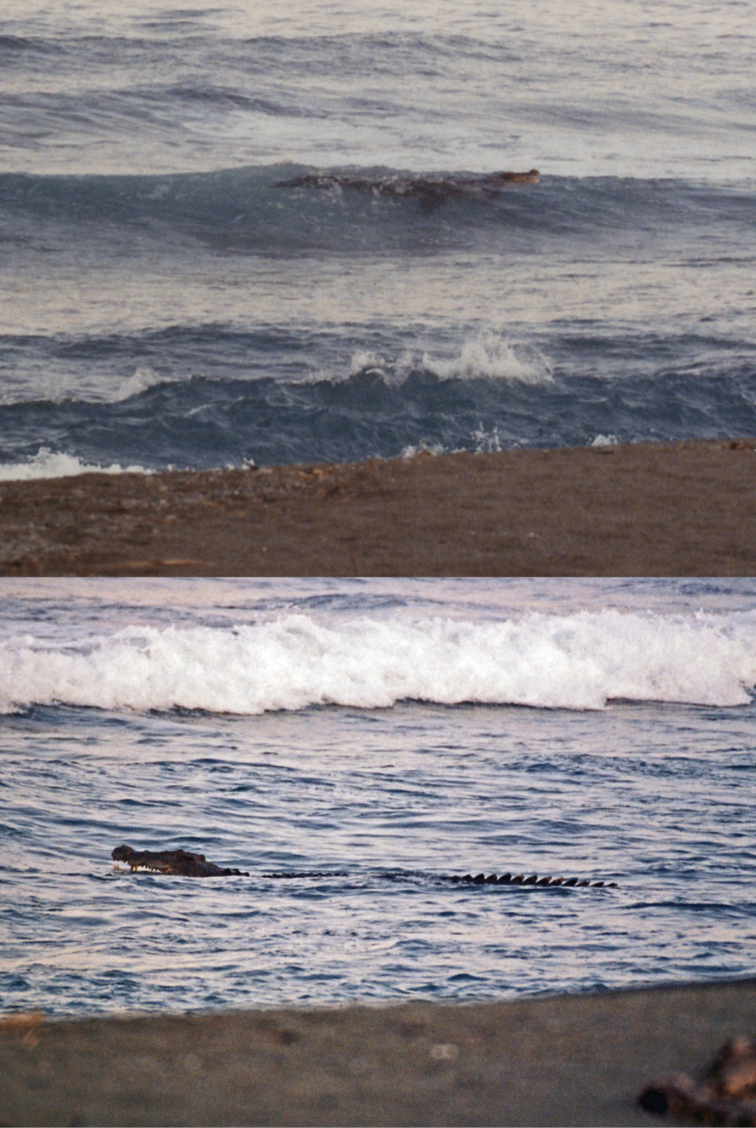
Crocodylus porosus foraging in surf at Maconacon, March 2004. Photo MVW.